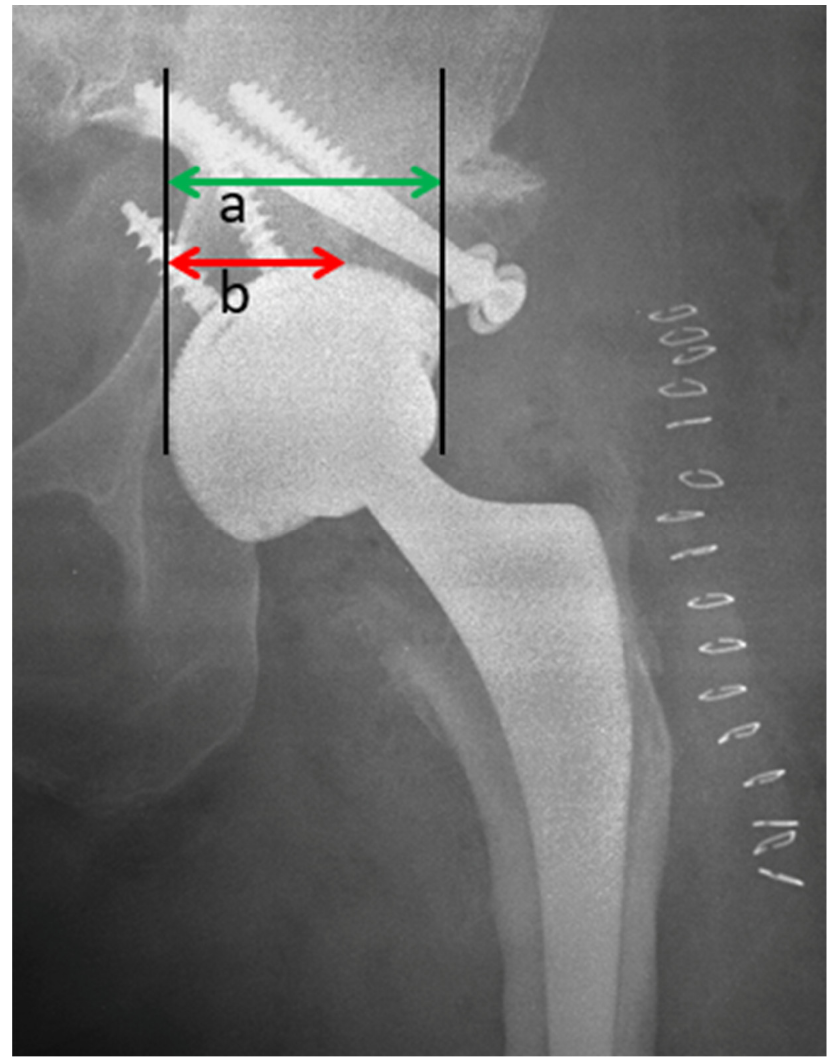
Figure 4. Horizontal Coverage defined as the: (horizontal host bone distance (b)/horizontal distance between the medial and lateral borders of the cup (a)) × 100.